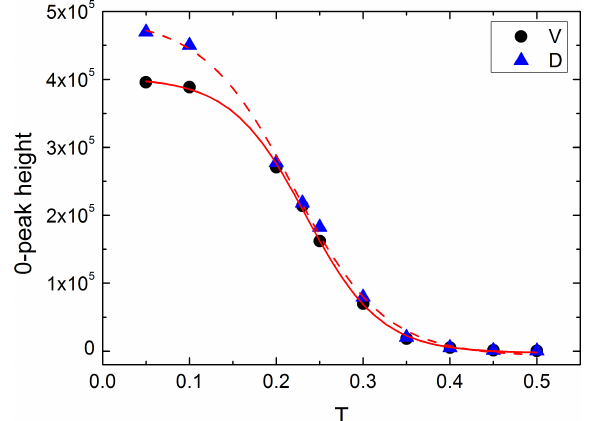
Figure 15. Plots of the amplitudes of the peaks for V ( (cid:126) r ) = 0 (black circles) and D ( (cid:126) r ) = 0 (blue triangles) against temperature. Red solid and dashed lines represent Boltzmann fits, Equation